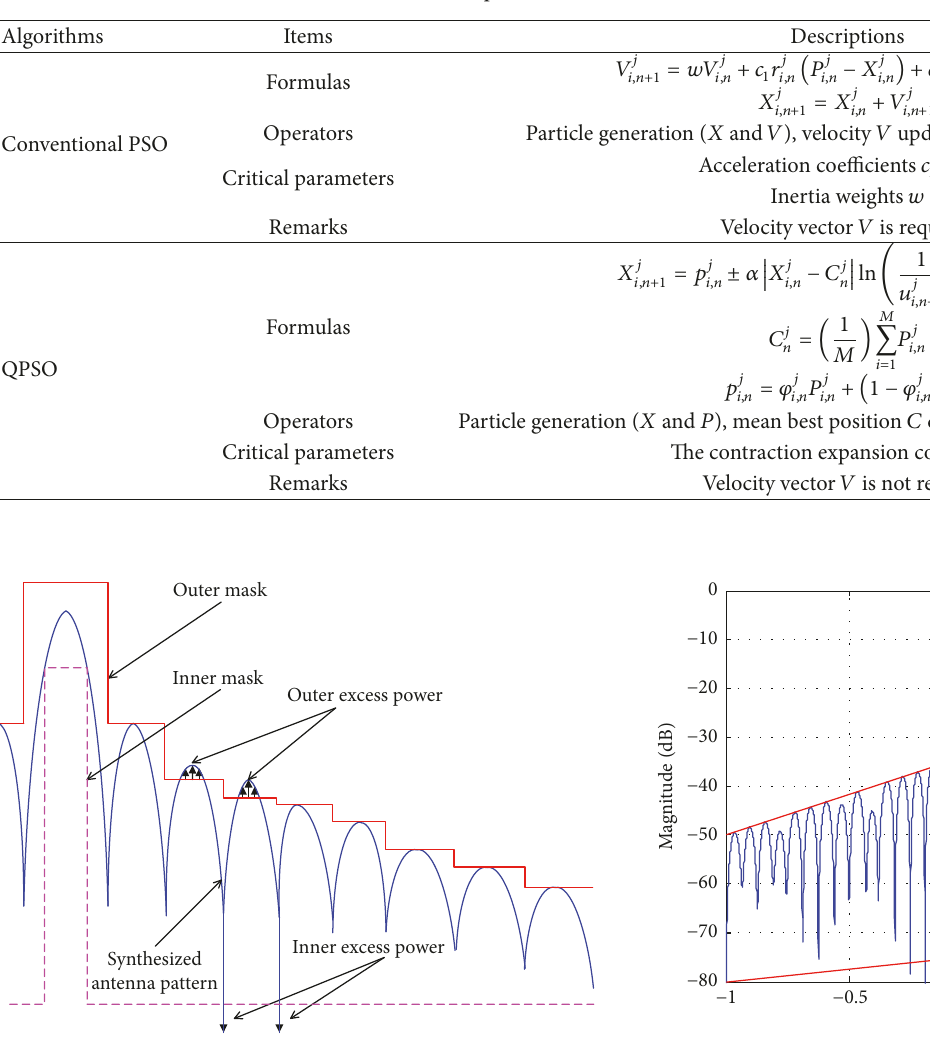
Table 1: Comparison of the conventional PSO and QPSO.